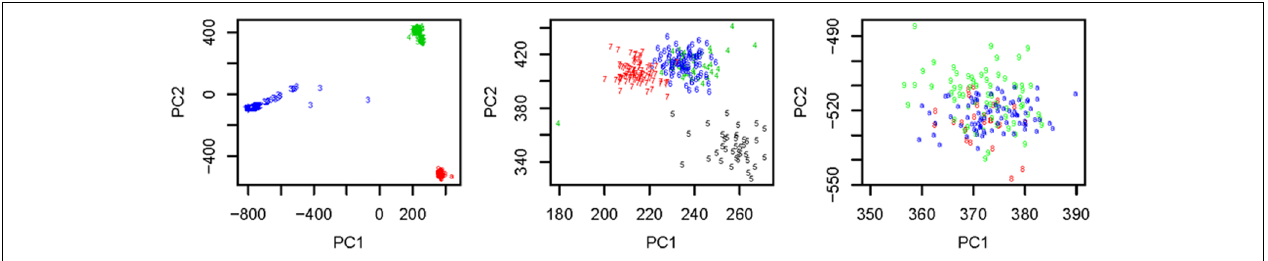
FIGURE 1 | Left: Top: 2 PCs after PCA dimension reduction for the SNV data from chromosomes 1-22, where subjects are self-identified as EUR (green), AFR (blue) and ASN (red). Middle: